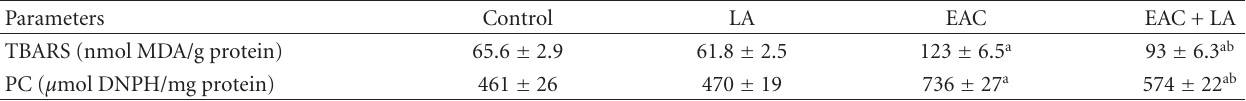
Table 4: Concentrations of thiobarbituric acid reactive substance, TBARS, and protein carbonyl PC in liver of di ff erent animal groups. Parameters TBARS (nmol MDA/g protein) PC ( μ mol DNPH/mg protein) 461 ± 26 470 ± 19 736 ± 27 a 574 ± 22 ab